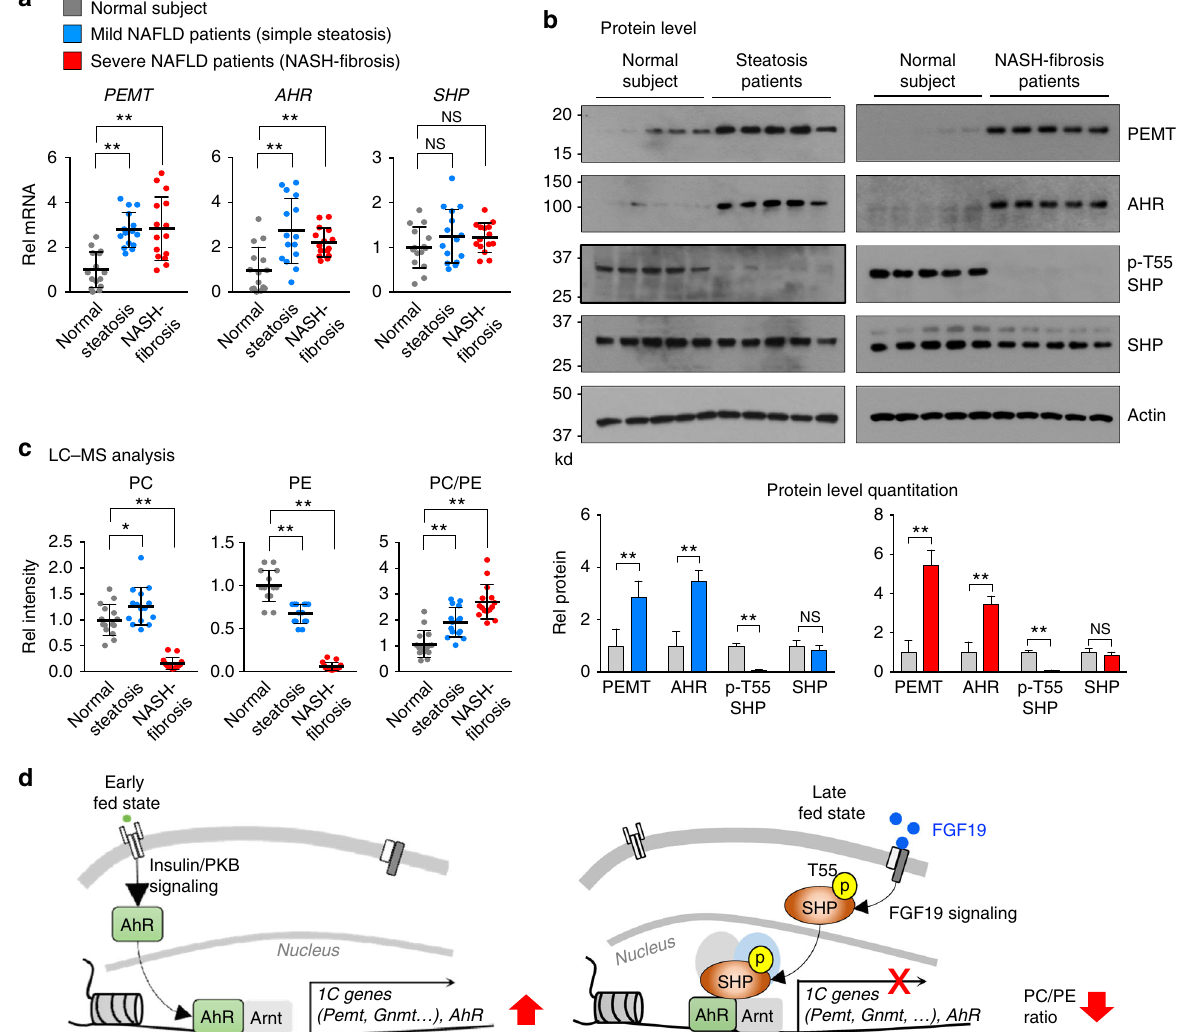
Fig. 8 Elevated AHR, PEMT, and PC levels in livers of NAFLD steatosis and NASH patients. a mRNA levels of PEMT , GNMT , and AHR in liver samples of 15 normal, 15 simple steatosis, and 15 severe NASH- fi brosis patients were determined by qRT-PCR. b Protein levels of PEMT, AHR, phosphorylated T55-SHP, and SHP in liver extracts from 5 samples each randomly pooled from 3 individuals (total 15 individuals) were analyzed by IB analysis (top) and the band intensities were quanti fi ed (bottom). The same normal samples were analyzed as controls in the two separate gels. Full size immunoblots are in Supplementary Figure 12e. c Hepatic PC and PE levels were determined by LC – MS and the ratios of PC/PE calculated. Means ± SD are shown ( n = 15), and statistical signi fi cance was measured using the b (bottom) Student ’ s t -test or a , c one-way ANOVA with the FDR post-test. * P < 0.05, ** P < 0.01, NS, not statistically signi fi cant. d Model: Temporal transcriptional regulation of the 1C cycle genes by a postprandial AhR – SHP axis. Nuclear levels of AhR are increased early after feeding by insulin/PKB signaling and nuclear AhR mediates transcriptional induction of 1C cycle genes, including Pemt and AhR , which results in increased hepatic PC and decreased SAM levels. In the late fed state, SHP blocks this AhR action through FGF15/19